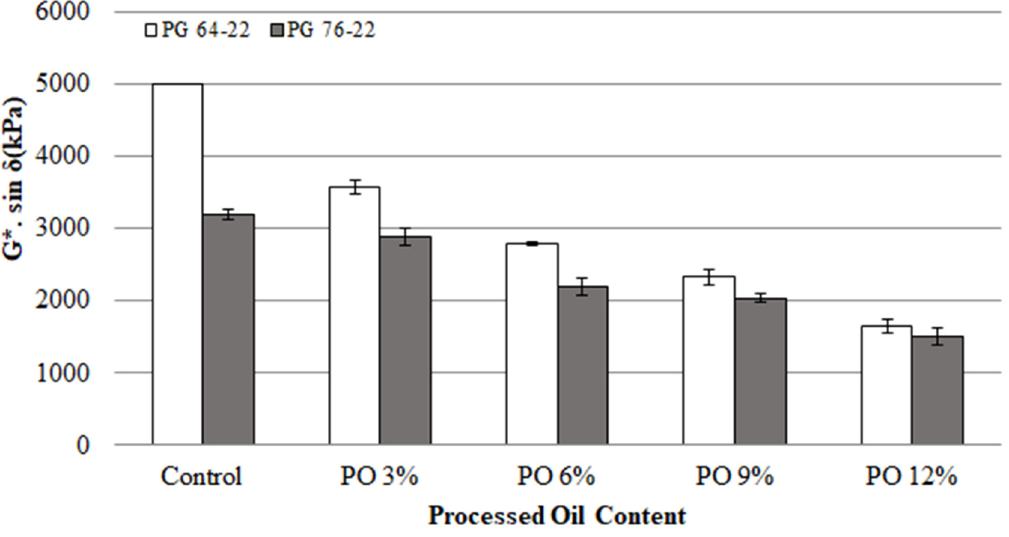
Figure 7. G*sin δ of the RTFO + PAV asphalt binders with processed oil at 25 °C. Table 7. Statistical analysis results of the G*sin δ as a function of processed oil content ( = 0.05).